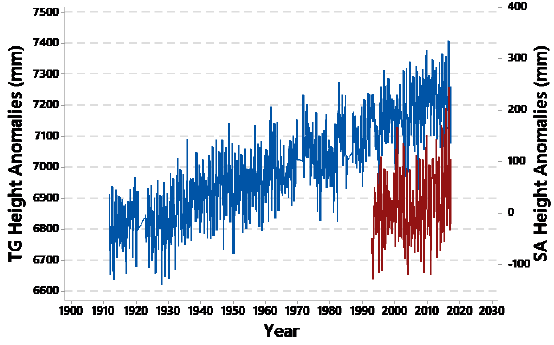
Fig. 1. Overlapping Atlantic City TG (in blue) and SA monthly sea level measurements used in this study. Each time series refers to its own